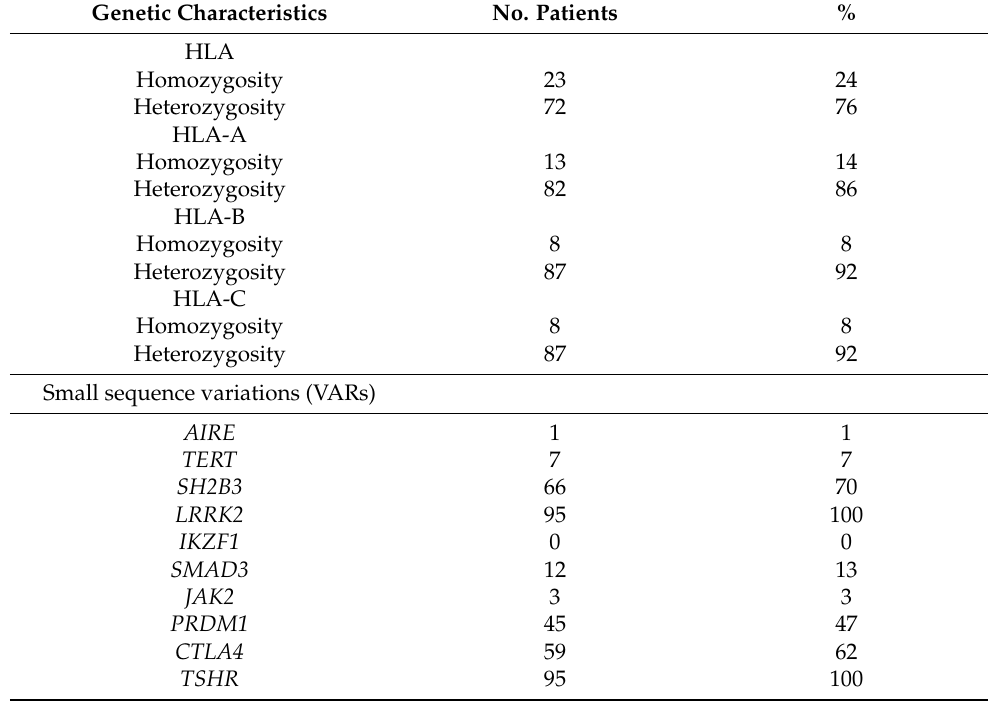
Table 2. Genetic characteristics of the